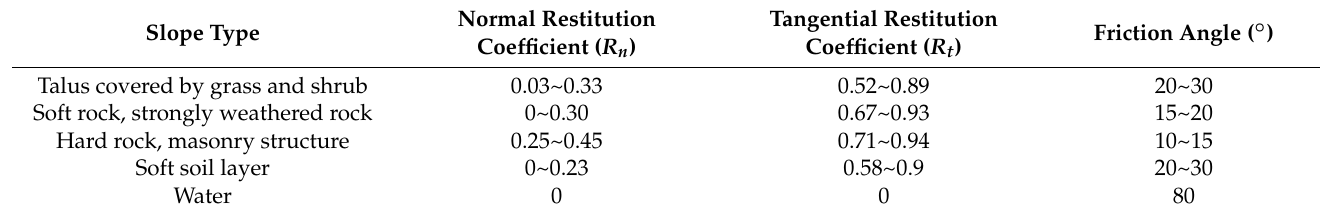
Table 7. Properties of the underlying surface